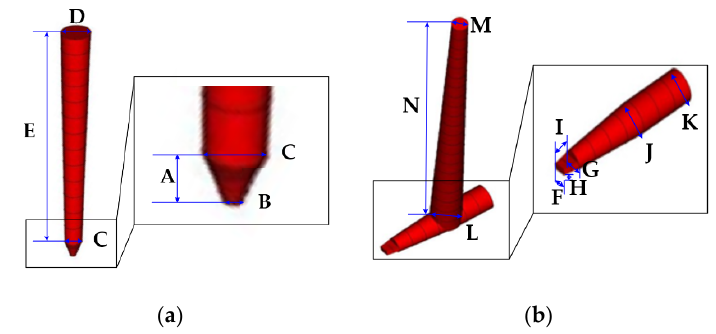
Figure 4. Detailed runner system. ( a ) Pivot sub-assembly. ( b ) Open lever. Table 4. Specification of runner system. Table 5. Specification of injection machine.